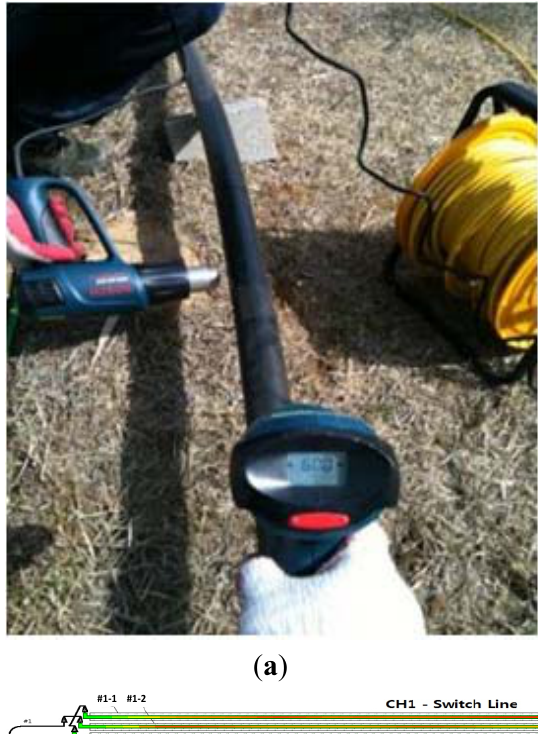
Figure 10. Verification of intelligent cable monitoring system: ( a ) cable heating using heat gun; and ( b ) screenshot of the branch line section